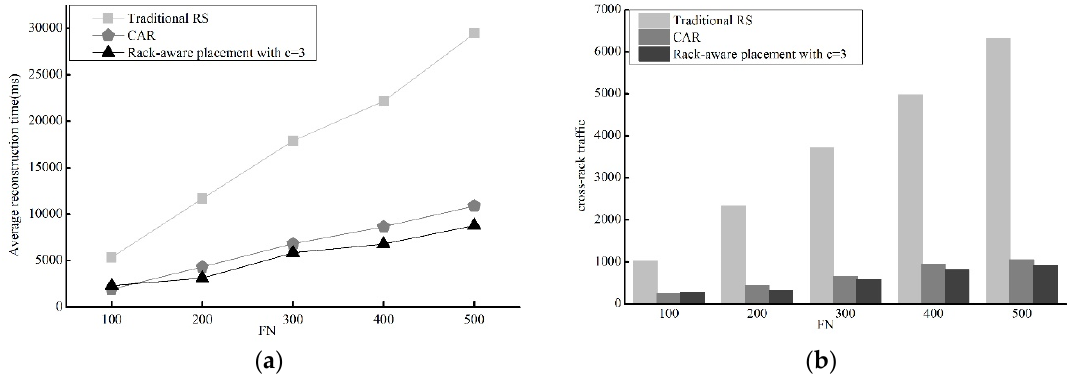
Figure 8. Performance evaluations of Traditional RS, CAR and our Rack ‐ aware placement with c =3. ( a ) Average reconstruction time; ( b ) Cross ‐ rack transmission frequency.